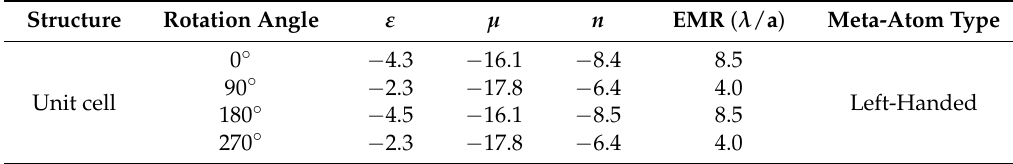
Table 2. Real values of ε , μ and n at 9.20 GHz. EMR, effective medium ratio.